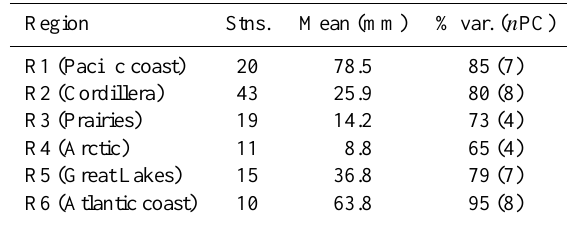
Fig. 1. Spatial distribution of the Canadian stations, with different symbols used to indicate the six geographic regions determined by a cluster analysis. The shading illustrates the Canadian topography.